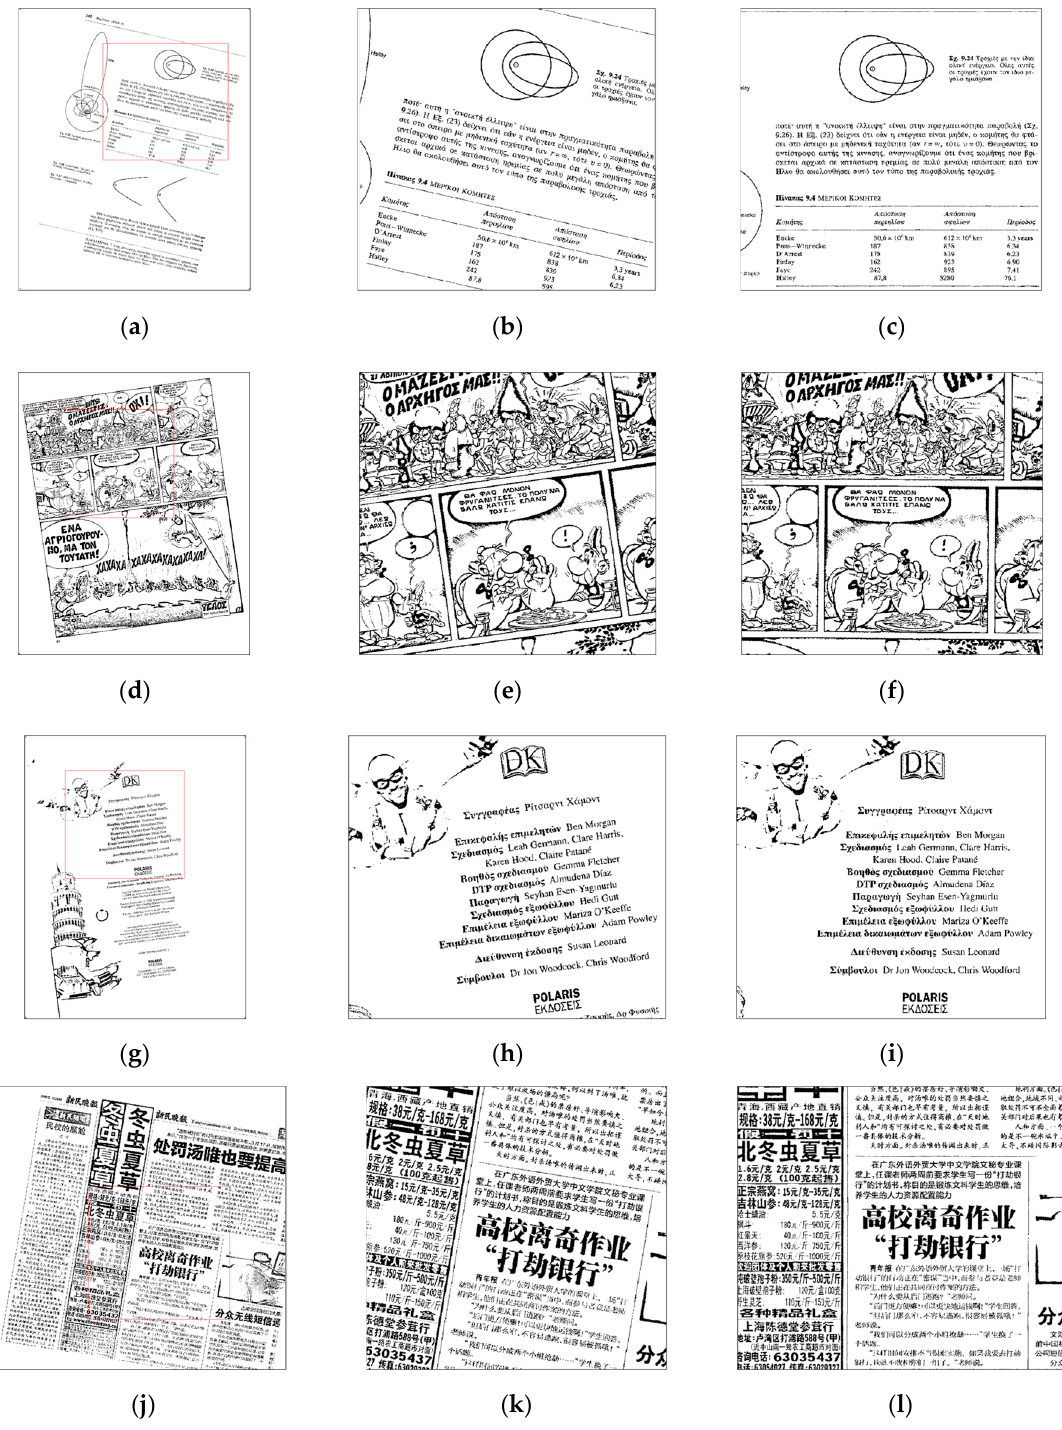
Figure 5. The rectification results of different type of document images with distinct angles: ( a , d , g , j ) are original images with skew angles of − 12.78 ◦ , 8.24 ◦ , 7.30 ◦ , and − 9.52 ◦ respectively; ( b , e , h , k ) are the parts of ( a , d , g , j ), respectively, which are surrounded by red rectangles; ( c , f , i , l ) are the corresponding correction result of ( b , e , h , k ) using our method, and the detected skew angles are − 12.84 ◦ , 8.08 ◦ , 7.29 ◦ , and − 9.41 ◦ ,